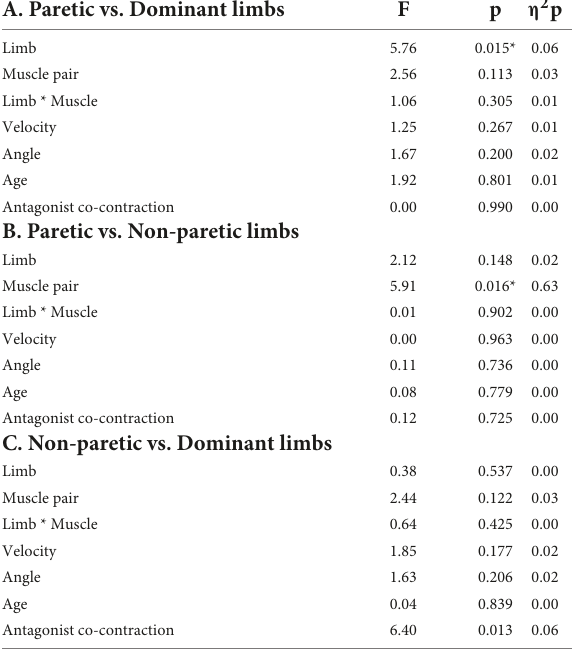
TABLE 2 Results of ANCOVAs performed between the paretic limb of stroke subjects and the dominant limb of control subjects (A), the paretic and the non-paretic limbs of stroke subjects (B) and the non-paretic limb of stroke subjects, and the dominant limb of control subjects (C). There were a limb factor and a muscle pair factor (BB-BR et TB-BR) with four covariables: Velocity (average velocity of the IMC quantification window), Angle (average angle of the IMC quantification window), Age of subjects, and Antagonist